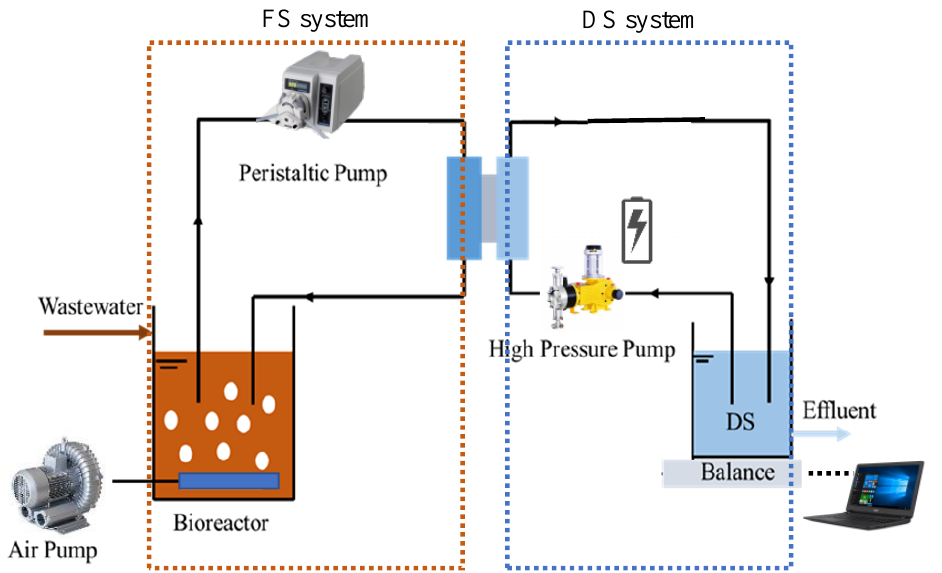
Figure 1. Schematic diagram of the laboratory-scale PRO-MBR system.